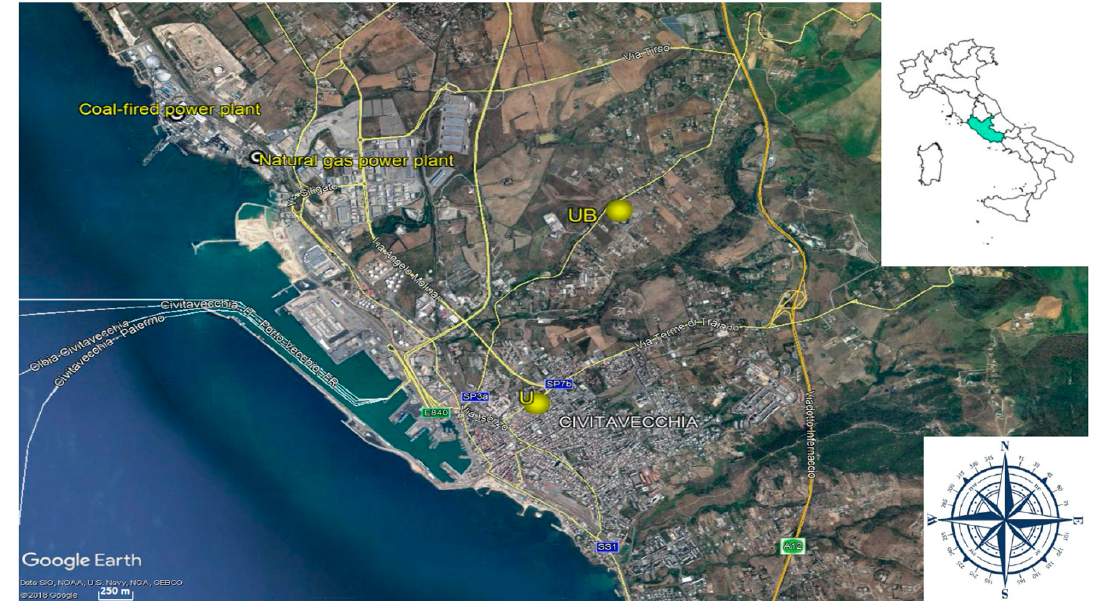
Figure 2. Map of the harbor-industrial area in Civitavecchia—the coal-fired power plant, the natural gas power plant and the two sampling sites, that is, U located in downtown Civitavecchia and Urban Background (UB) located outside the urban area, are identified.